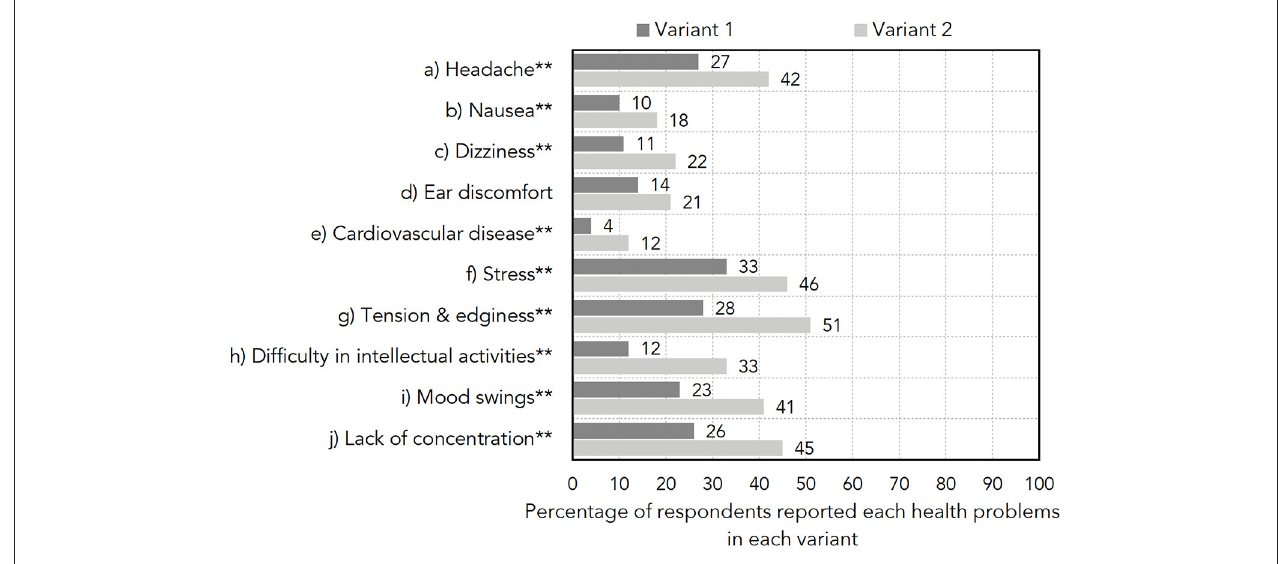
FIGURE 2 | Clustered bar chart showing the percentage of respondents reporting health problems in Variants 1 and 2 (**significant differences across variants with p < 0.05 for chi-squared tests).